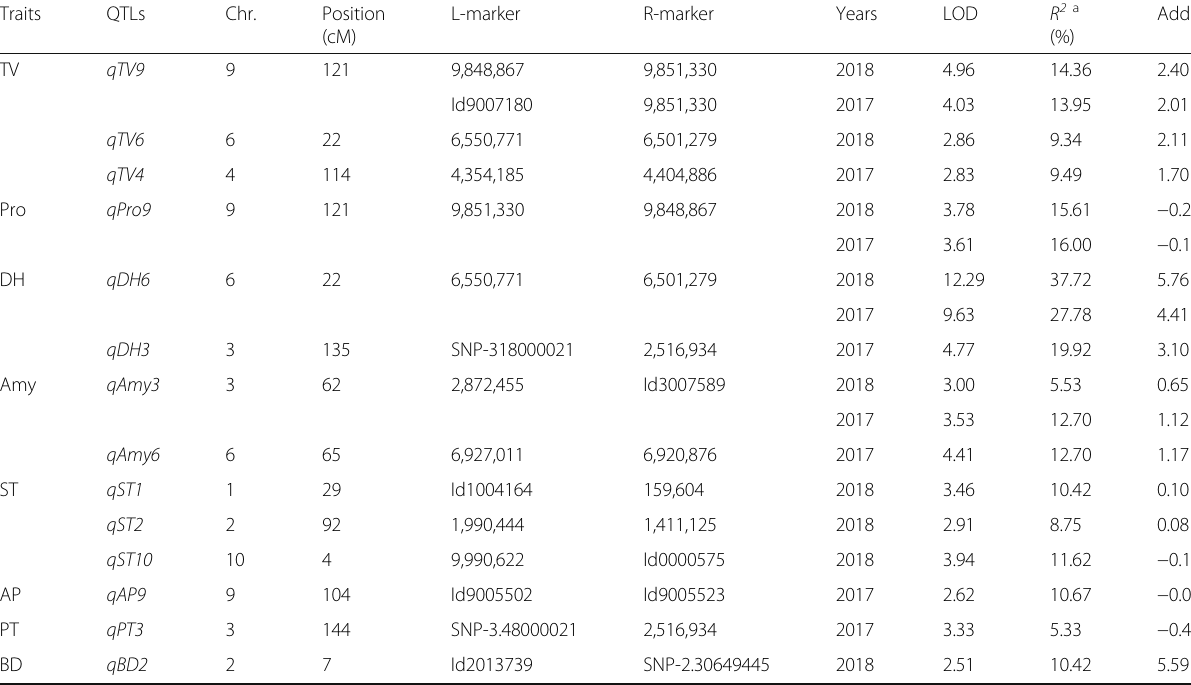
Table 4 QTLs identified for the traits of rice eating and cooking quality for 2 years in the RIL population Traits QTLs Chr. Position (cM)